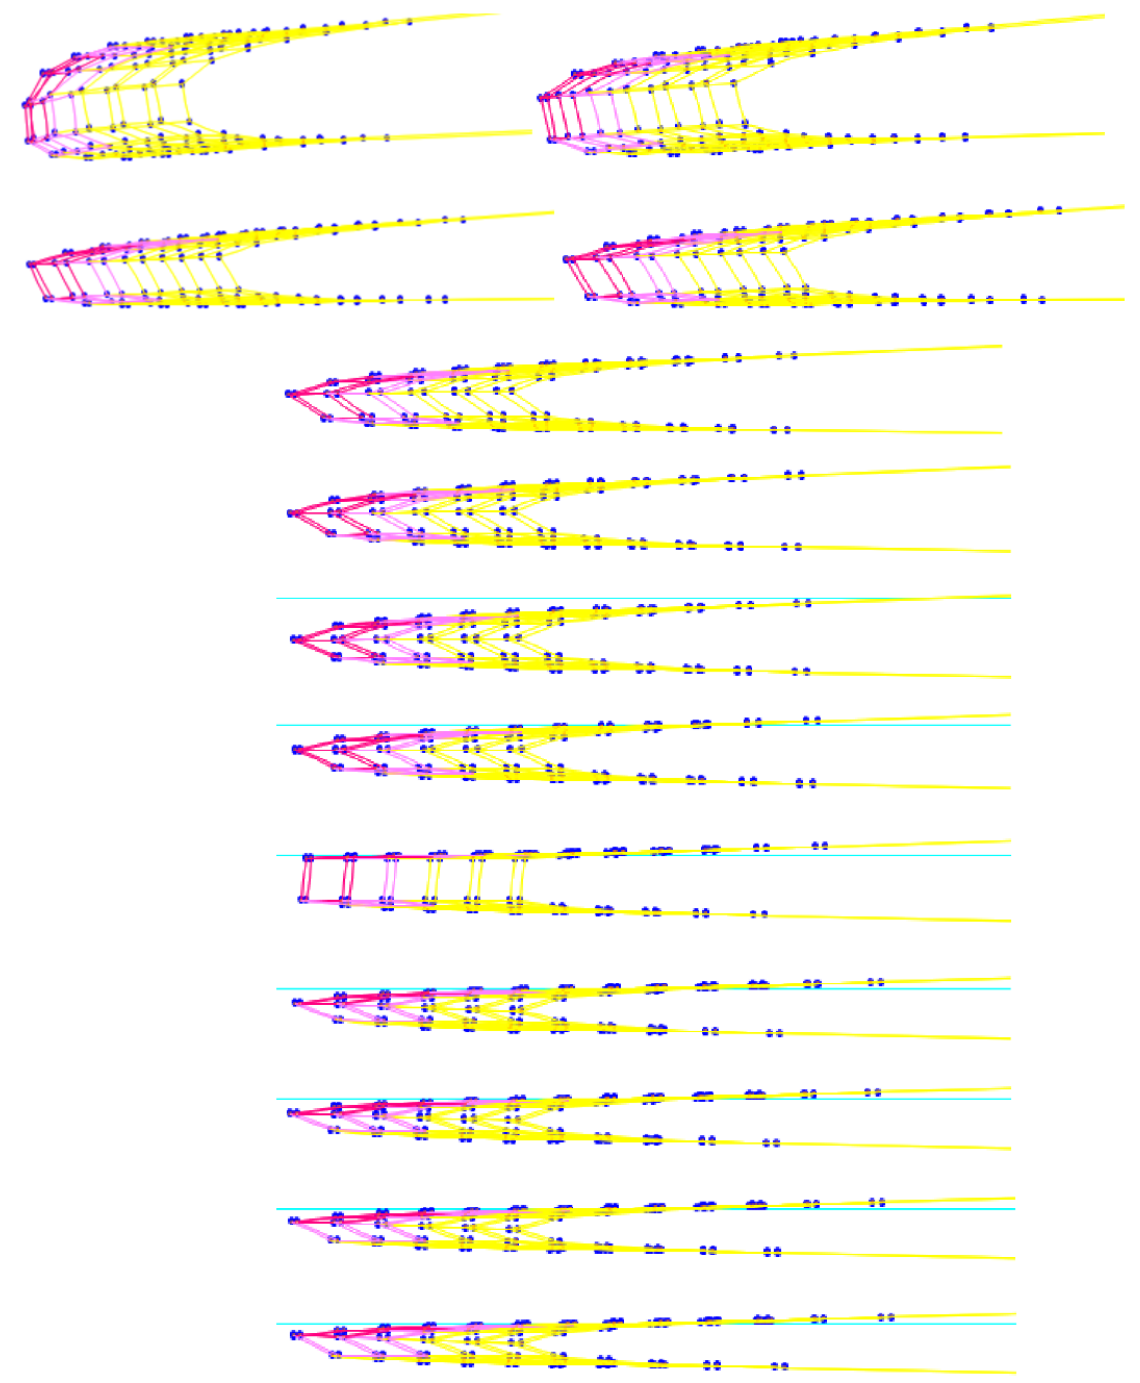
Figure 34. Shape changes of the flexible trawl in straight-line towing at v = 3 m/s.